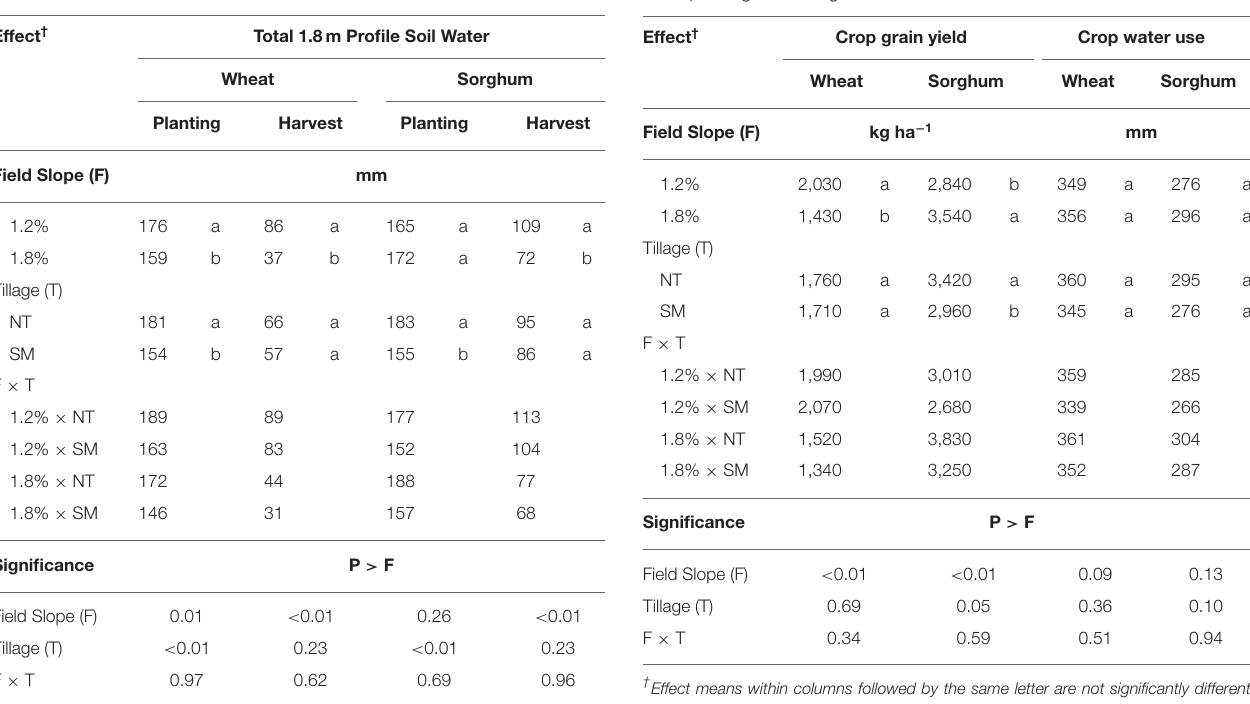
TABLE 2 | Mean 1.8m profile soil water, mm, at planting and harvest of wheat and sorghum in relation to the field slope, tillage, and interaction effects with the corresponding ANOVA significance levels.